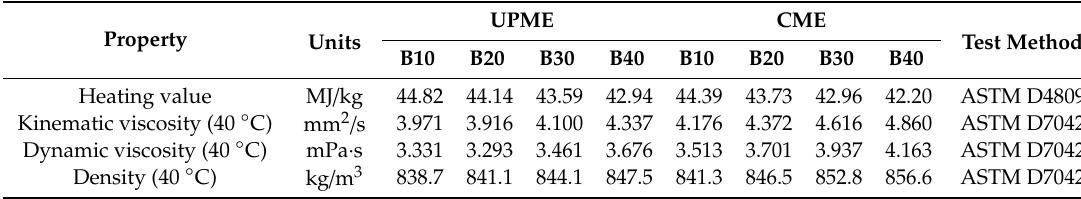
Table 2. The properties of methyl ester-diesel fuel